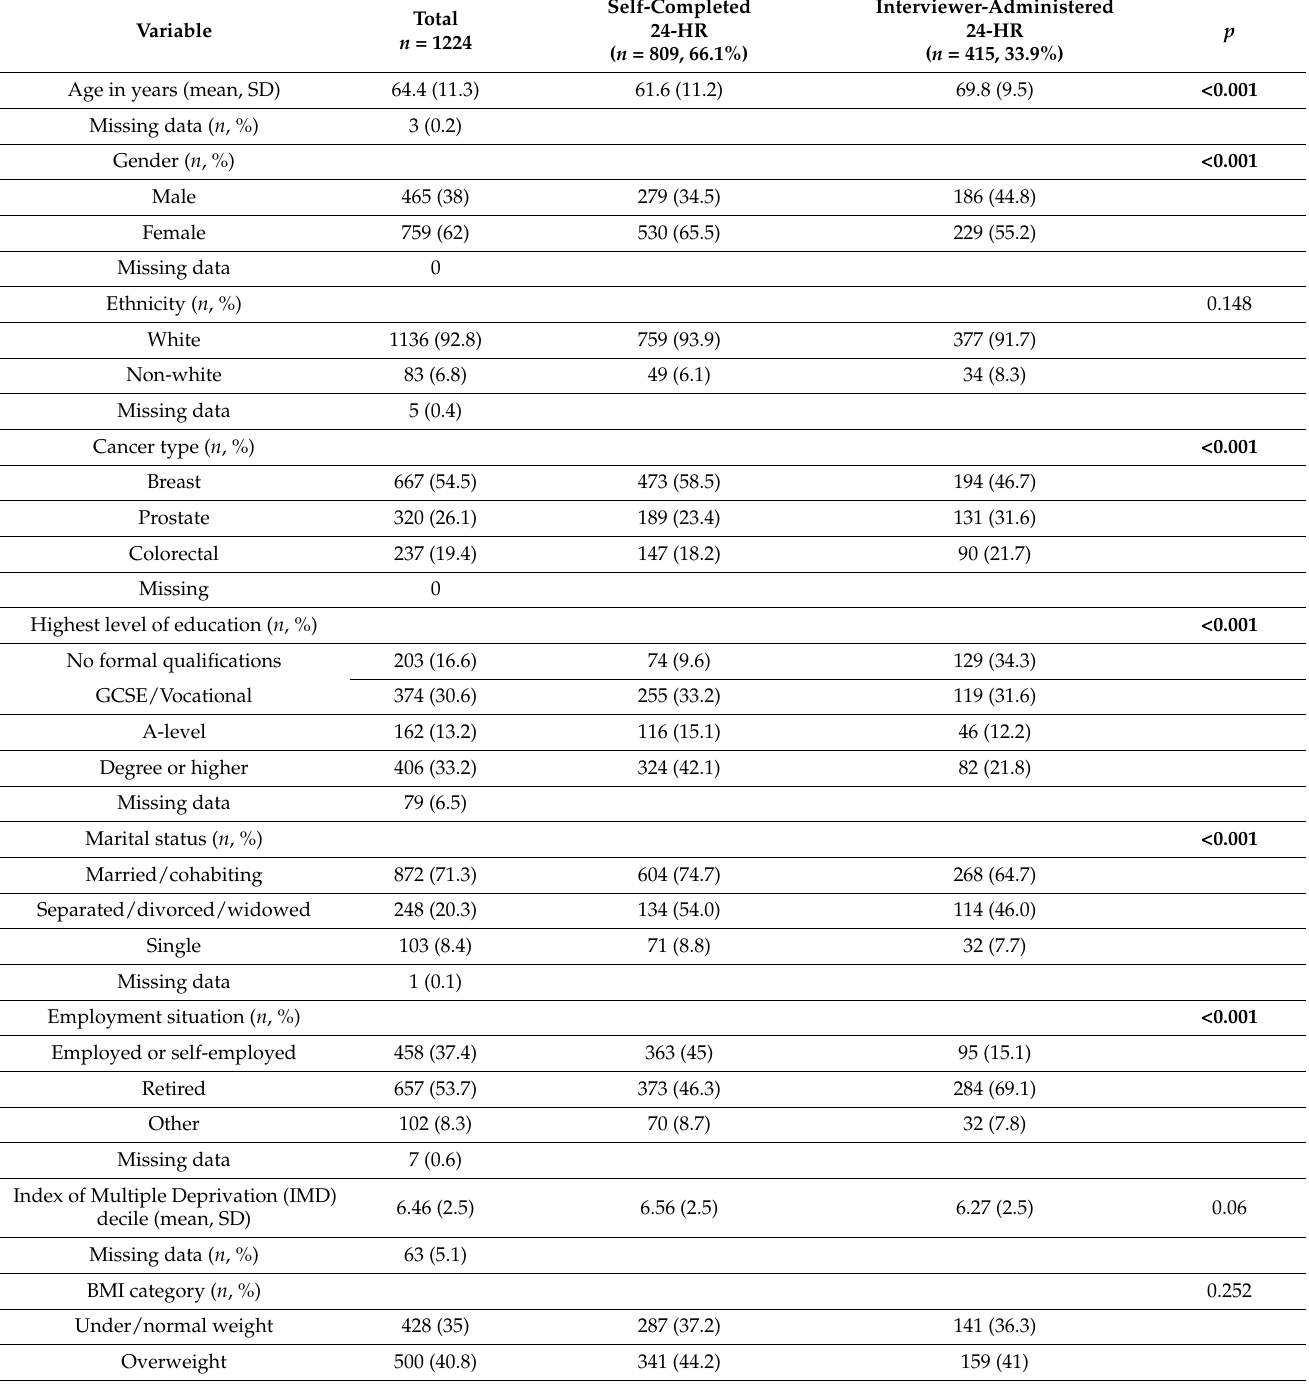
Table 1. Demographic data, clinical characteristics, internet and email use of cancer survivors,